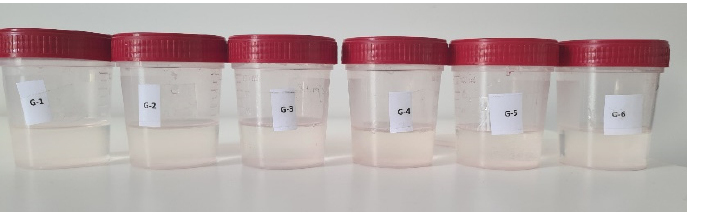
Figure 1. G1-G6 in situ gels with lyophilized aqueous extract of balsamic poplar buds 1% aqueous solution.